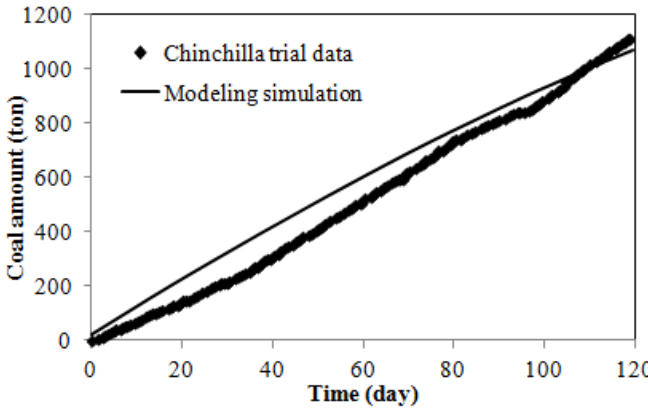
Figure 28. Coal consumptions for modeling and Chinchilla trial data [58].